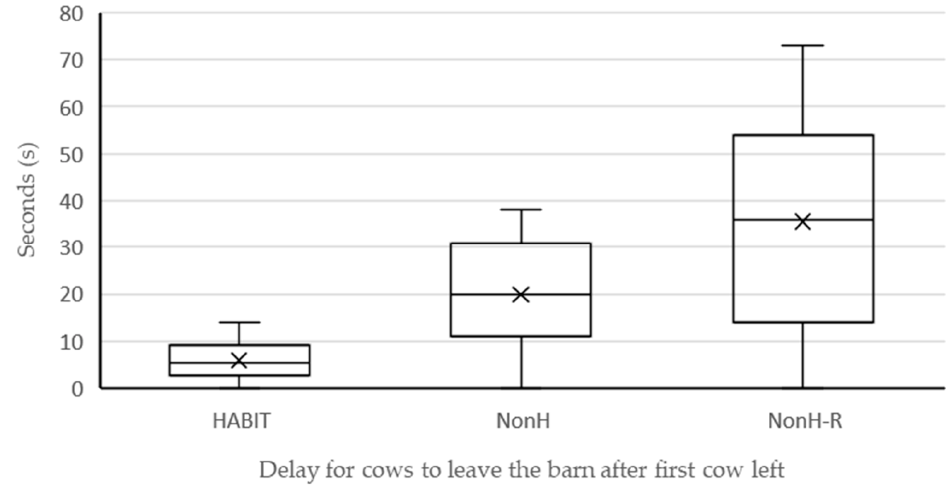
Figure 2. Boxplot graphs (bold line: median; cross: mean value; boxes: first and third quartile; whiskers: 5th and 95th percentiles) of time passed, depicted in seconds, between first cow and each following cow leaving the barn per group.